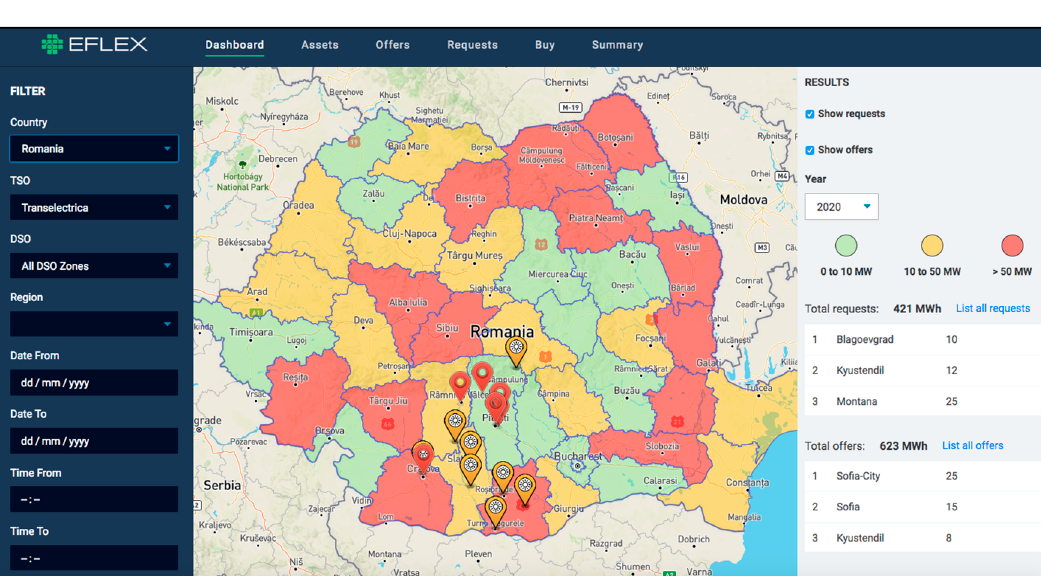
Figure 21. Flexibility assets in Romania.